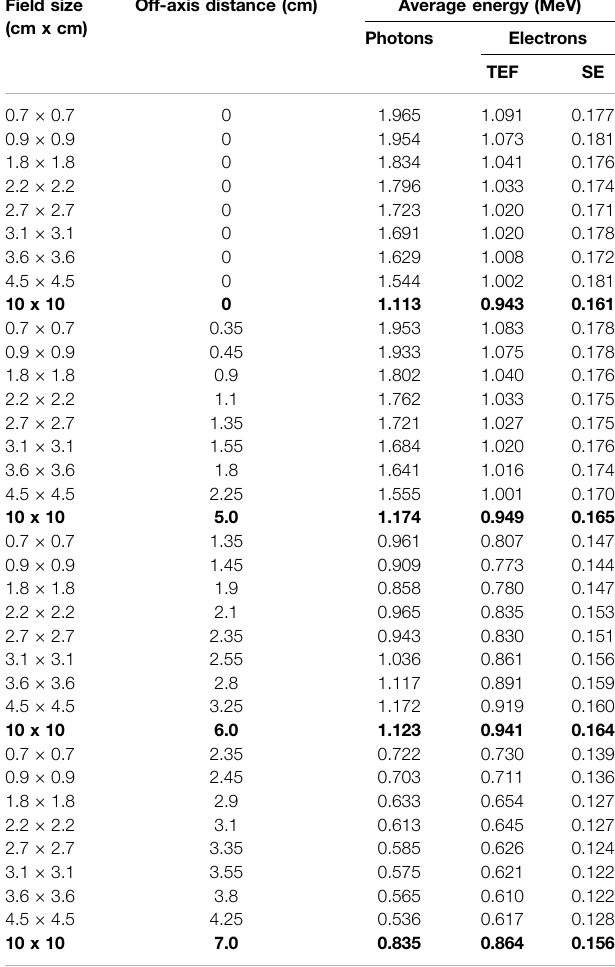
The bold indicates the end of each distance from the edge of the fi